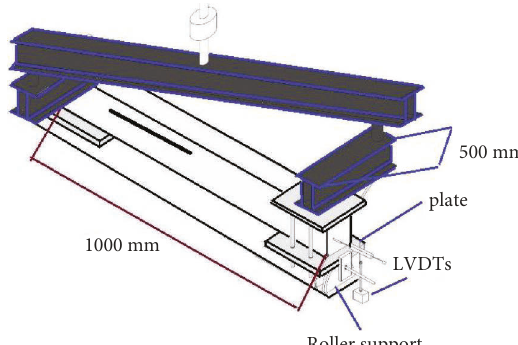
Figure 5: Typical cross section of the tested machine.